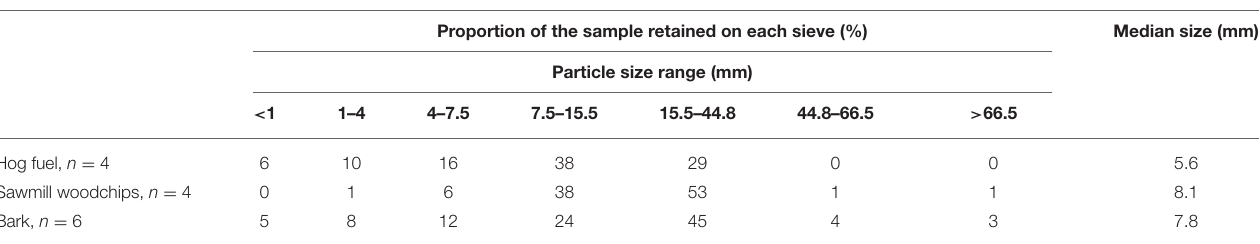
TABLE 4 | Average particle size distribution for the different woody biomass materials. Proportion of the sample retained on each sieve